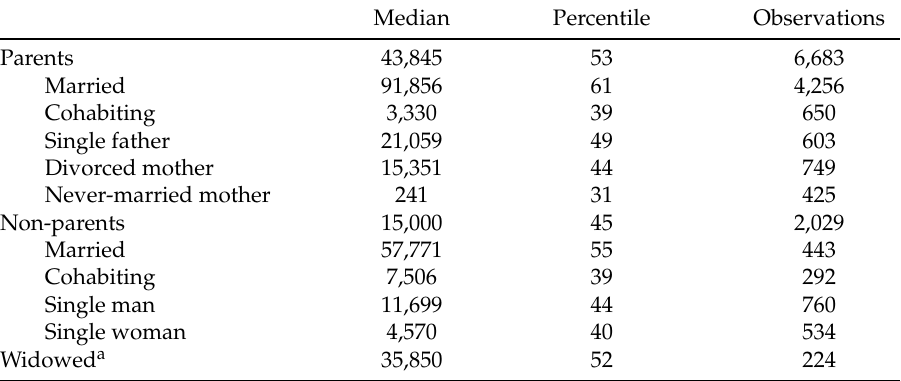
Table 1: Median wealth and mean percentile net worth by household type, 2016